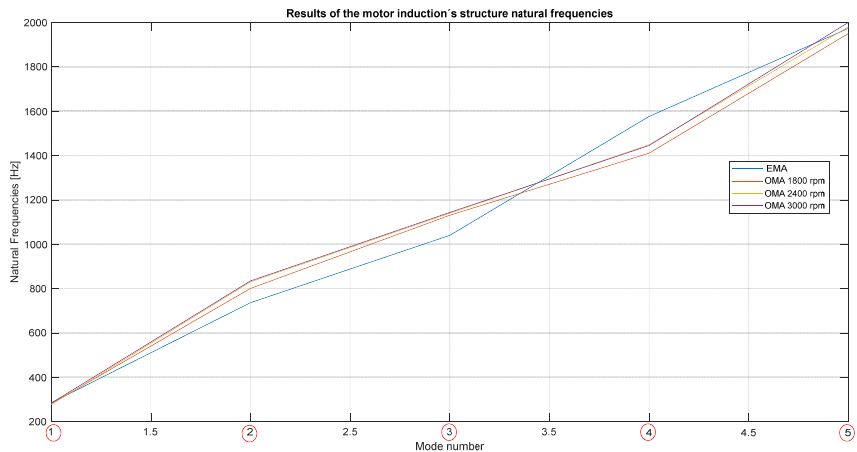
Figure 10. Comparison of the induction motor’s FRFs, with five modes at varying speeds (1800, 2400, and 3000 rpm).